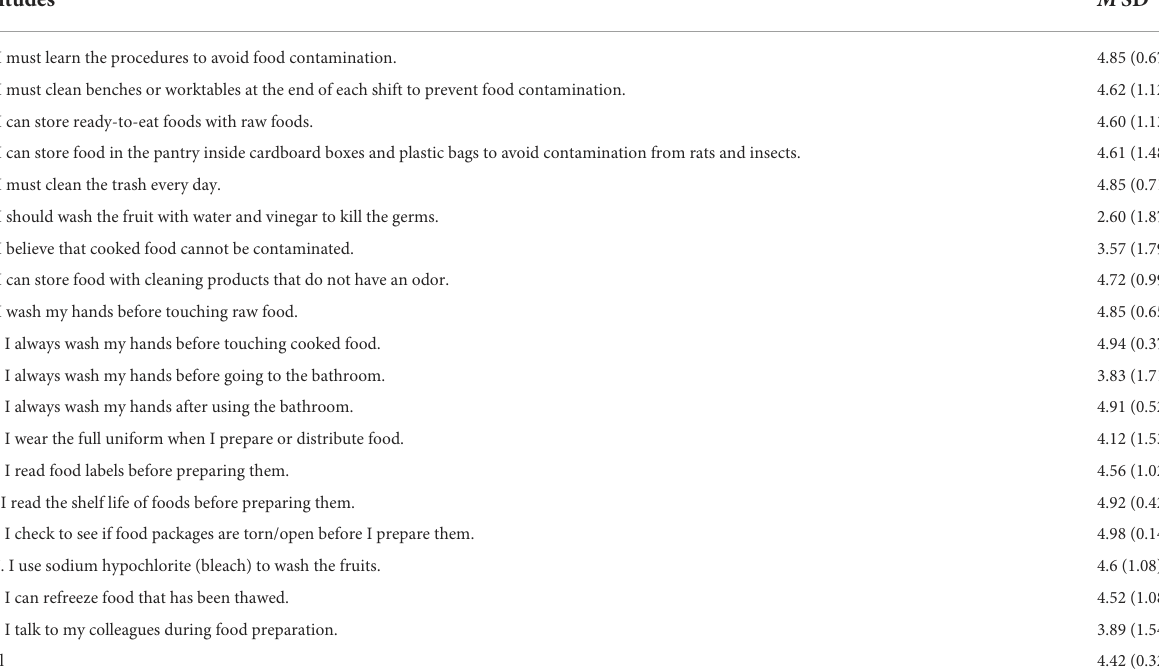
TABLE 5 Mean (M) and standard deviation (SD) attitude according to food handlers in the School Food Services (based on 5-point Likert scale responses). Attitudes M